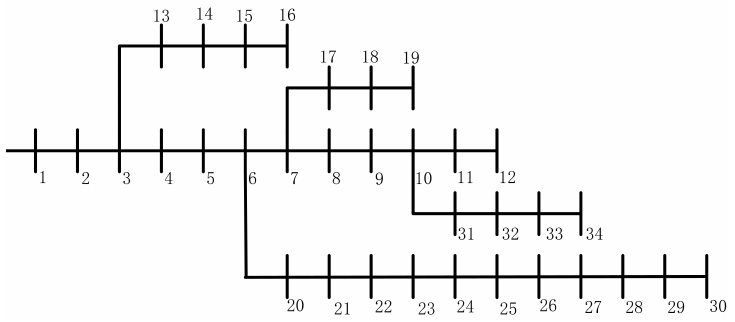
Figure 7. The 34 bus radial distribution